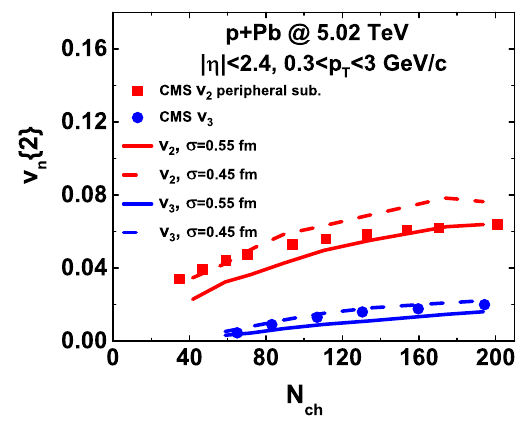
Fig. 9 Integrated charged hadron v 2 and v 3 at | η | < 2 . 4 and 0 . 3 < p T < 3GeV / c asafunctionofmultiplicityin5.02TeVp+Pbcollisions for two different choices of Gaussian width: σ = 0 . 55 and 0.45 fm, compared to data from the CMS Collaboration